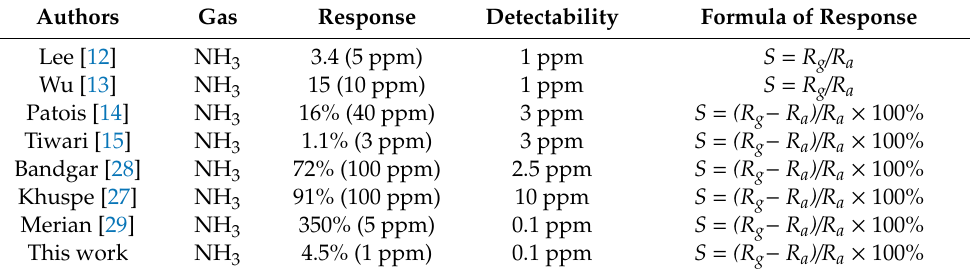
Table 2. Performances of various ammonia gas sensors.